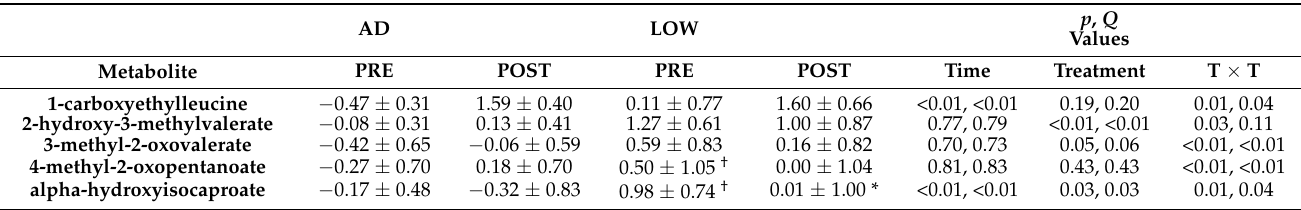
Figure 4. Mean ± SD of change in urea ( A ) and 3-methylhistidine ( B ) from BASELINE to PRE and POST aerobic exercise following 24 h of refeeding to elicit adequate (AD) or low (LOW) glycogen stores. n = 11, * Different from PRE; p < 0.05, Q < 0.10. † Different from AD ; p < 0.05, Q < 0.10. Table 2. Branched-chain amino acid metabolites .